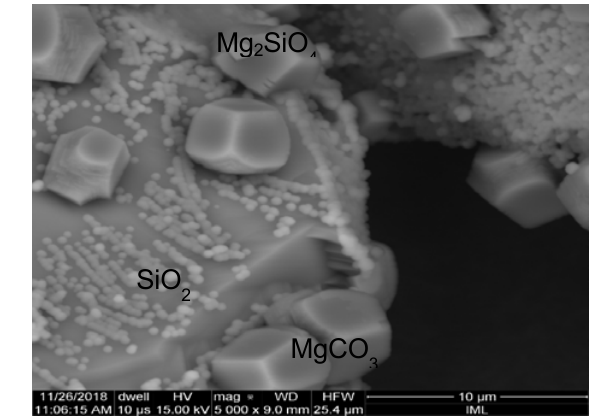
Figure 7 – SEM analysis of the initial olivine sample after